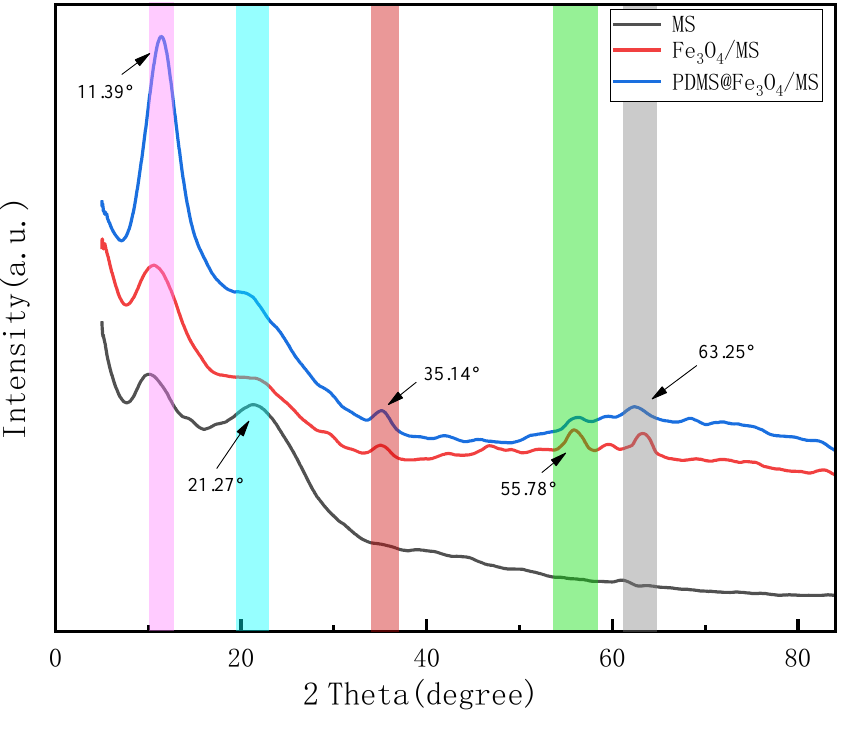
Figure 5. XRD patterns of MS, Fe 3 O 4 /MS and PDMS@Fe 3 O 4 /MS.